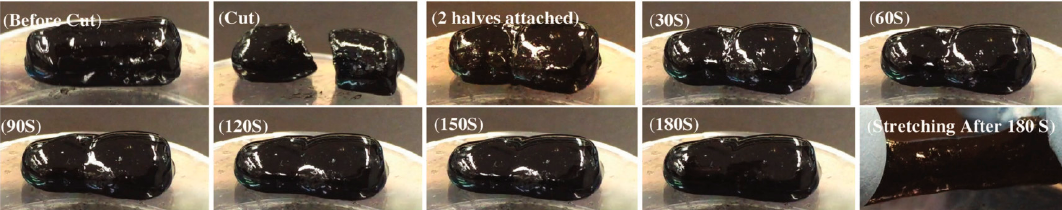
Figure 3. The conductive H2010h1 hydrogel by Darabi et al. exhibits self-healing over minutes (seconds since cutting shown in inset) with, importantly, the restoration of mechanical and electrical properties [22]. Adapted with permission from ref [22]. Copyright 2017 John Wiley and